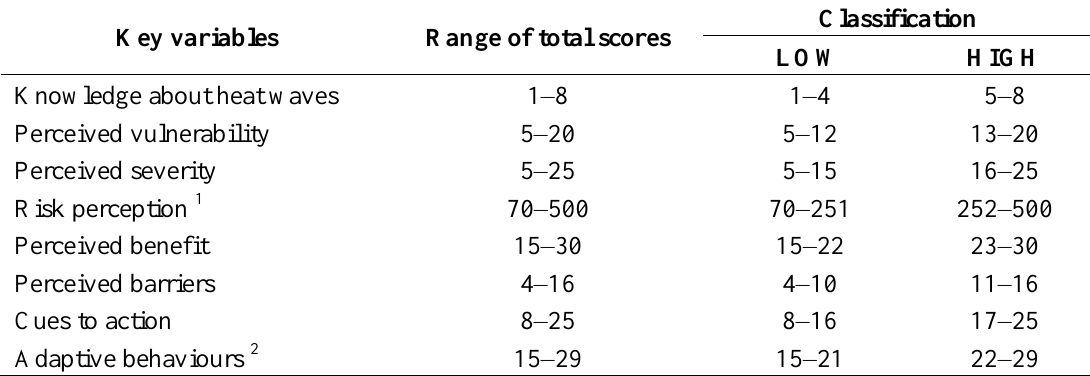
Table 1. Range and classification of scores for heat wave knowledge, perceptions and adaptive